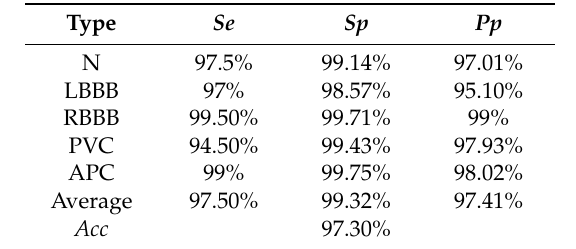
Table 5. The performance statistical indicators of the experiment results: sensitivity ( Se ) and specificity ( Sp ), and positive predictability ( Pp ).